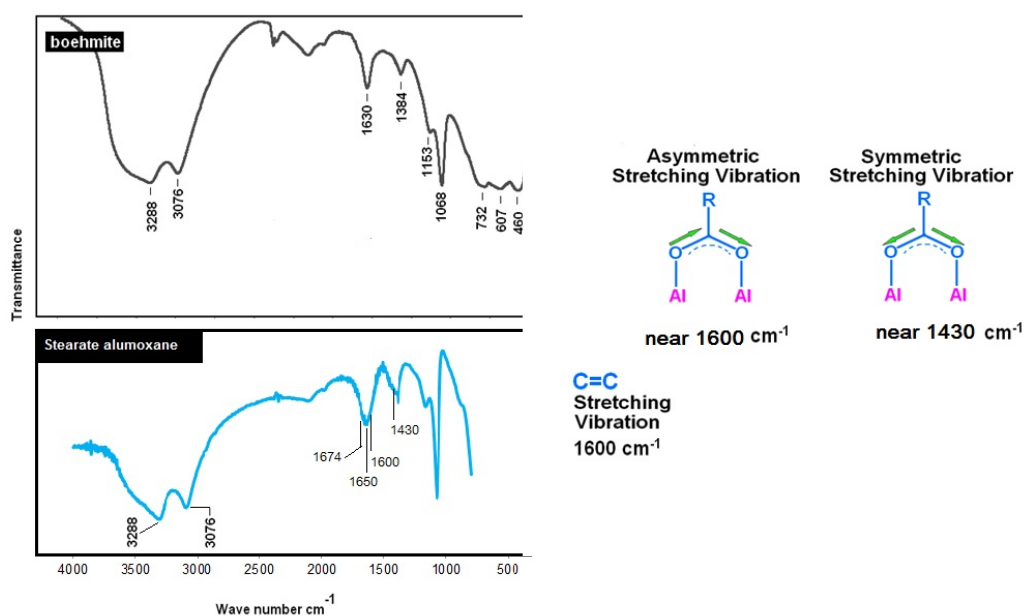
Fig. Fig. 4. FT-IR spectra of the boehmite and St-A nanoparticles. Fig. 4